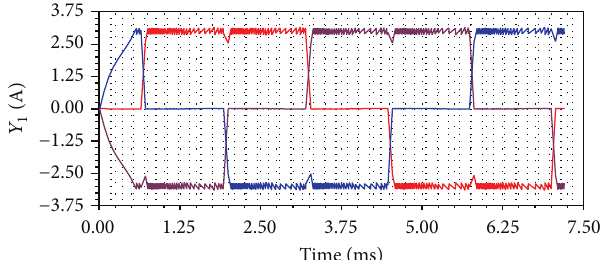
Figure 27: Three-phase current in hysteresis control mode (without filter).